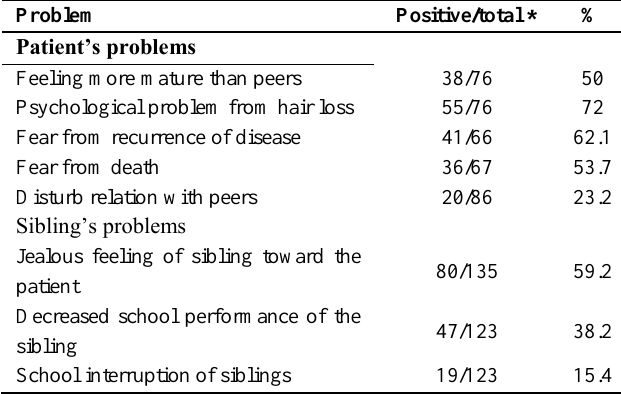
Table 5: Patients’ and sibling’